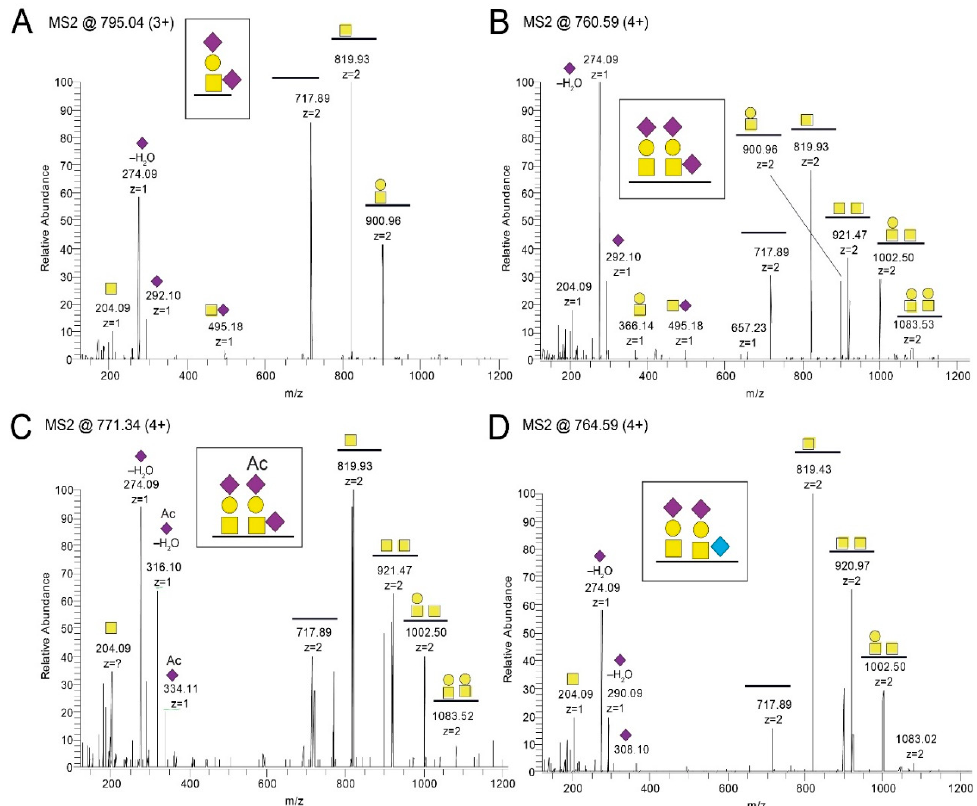
Figure 1. LC–MS/MS spectra after pronase and trypsin treatment of gE HP . Shown are representative spectra covering amino acid 325-TRNPTPAVTPQPR-337. T329 and T333 were found to ( A , B ) carry monosialylated and disialylated core 1 O-linked glycans. Also, ( C ) NeuAc(Ac) variants and ( D ) NeuGc variants were identified. In total, trypsin and pronase treatment resulted in 62% coverage of the total protein.